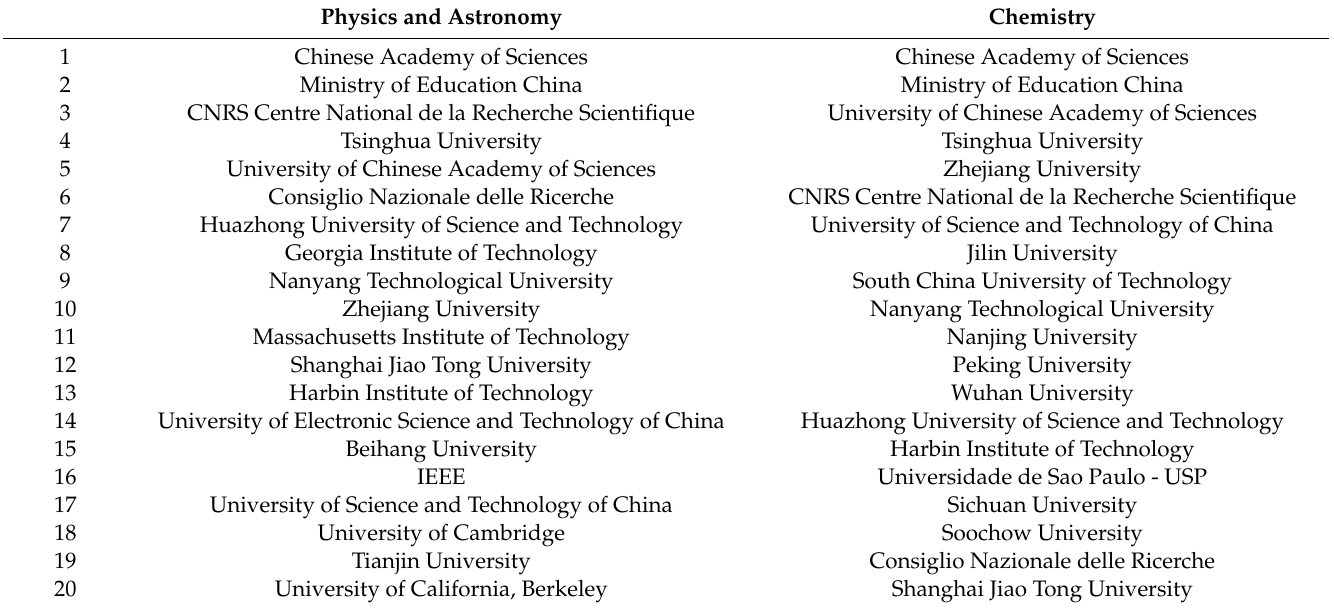
Table 5. Worldwide publications by a ffi liation / university on low cost for the categories from 4 to 5. Physics and Astronomy